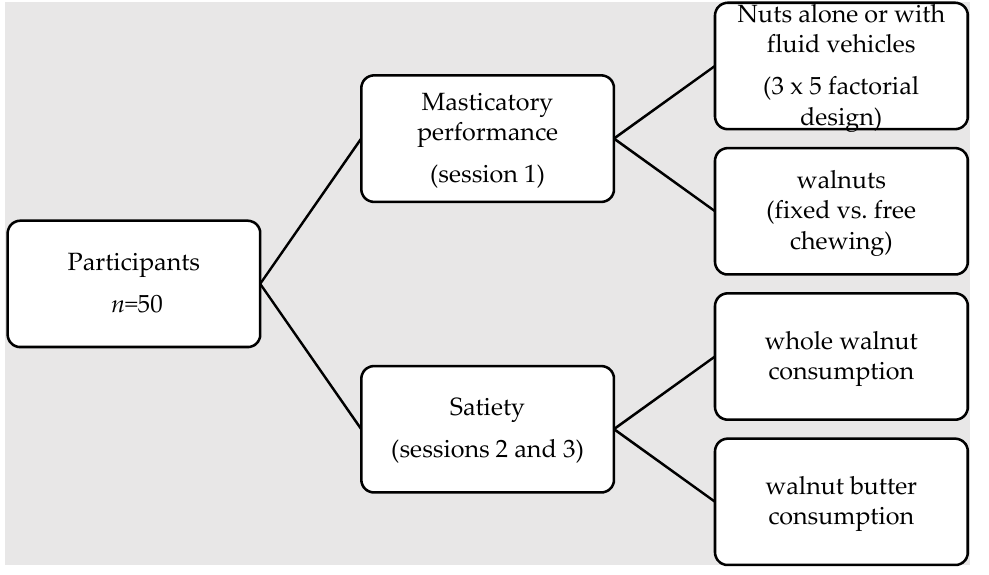
Figure 1. Study design flow diagram.